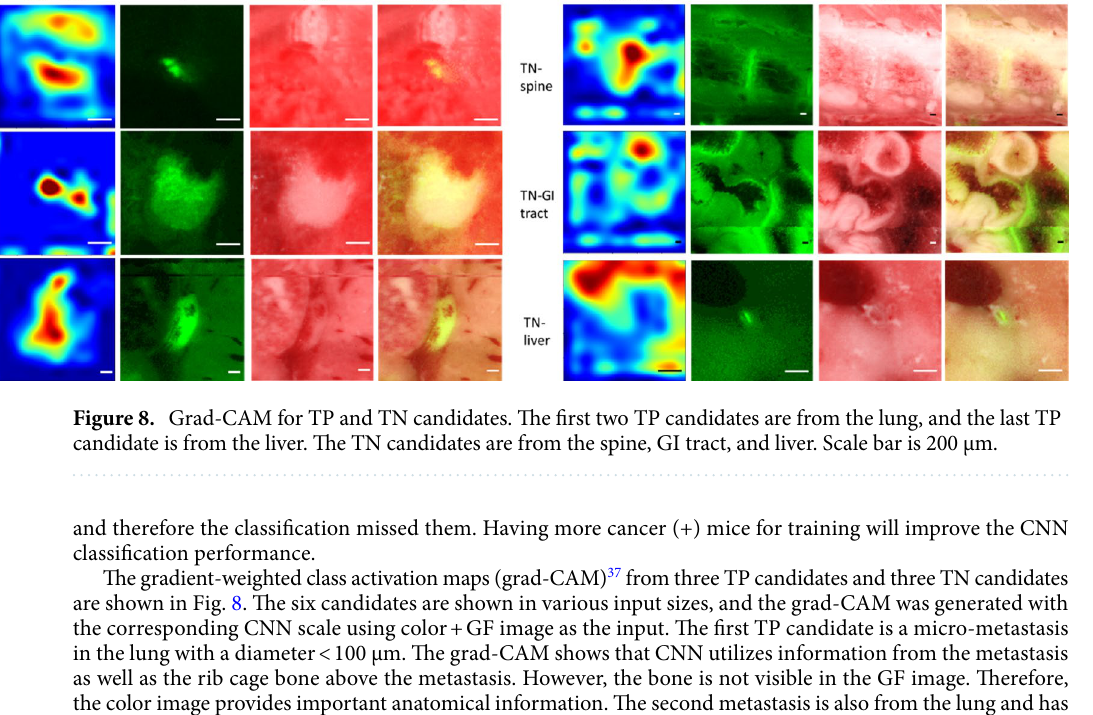
and therefore the classification missed them. Having more cancer (+) mice for training will improve the CNN classification performance. The gradient-weighted class activation maps (grad-CAM) 37 from three TP candidates and three TN candidates are shown in Fig. 8. The six candidates are shown in various input sizes, and the grad-CAM was generated with the corresponding CNN scale using color + GF image as the input. The first TP candidate is a micro-metastasis in the lung with a diameter < 100 µm. The grad-CAM shows that CNN utilizes information from the metastasis as well as the rib cage bone above the metastasis. However, the bone is not visible in the GF image. Therefore, the color image provides important anatomical information. The second metastasis is also from the lung and has diameter ~ 600 µm. The grad-CAM has strong response where the fluorescence intensity is high in the metas- tasis. Metastases bigger than 500 µm generally have a white appearance on the color image that could assist in classification. The TN candidate in the liver is auto-fluorescence from the bile duct in the liver. We can see that for the CNN, the vessel near the bile duct has the most weightage for making a cancer negative prediction. With grad-CAM, we revealed that our CNN is trained to focus on important fluorescence and anatomical information detected from color and GF images.